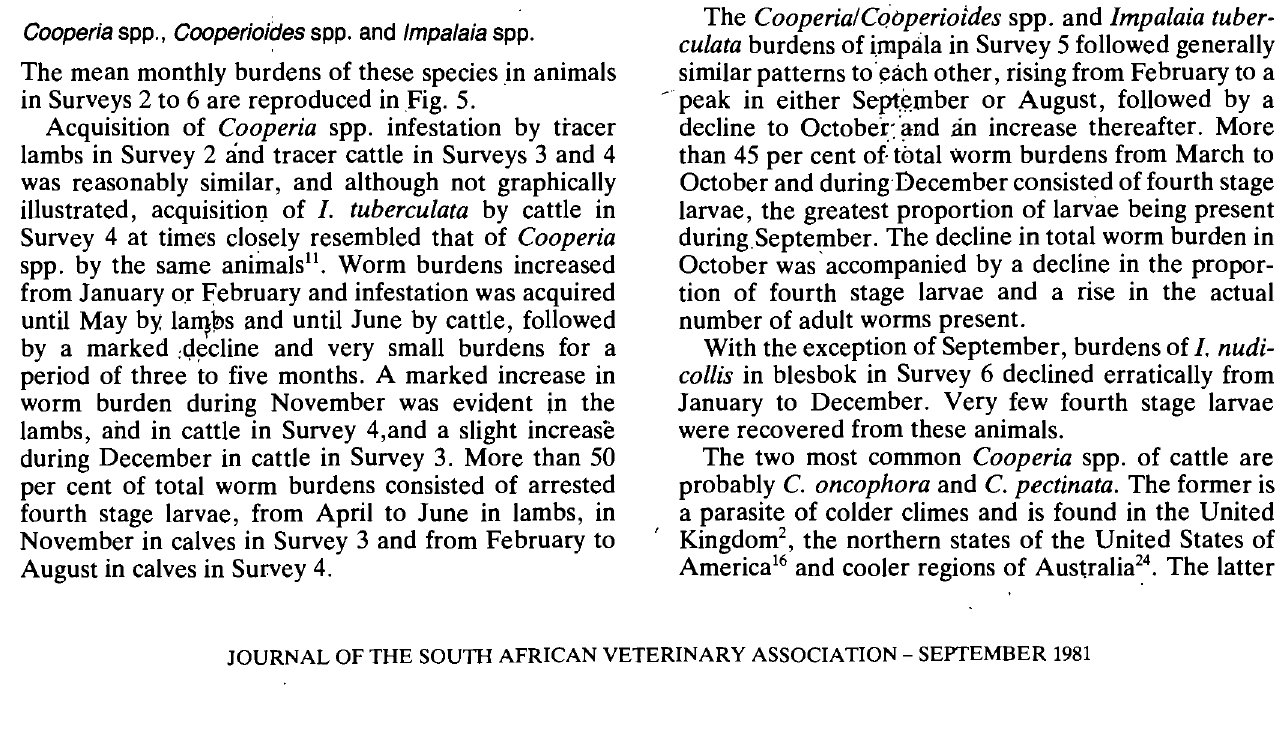
Fig. 5 The seasonal incidence of Cooperia spp. in sheep and cattle, Cooperia sp., Cooperioides spp. and Impalaia sp. in impala and Impala sp. in blesbok slaughtered in surveys conducted in the Transvaal. Survey 2 - sheep, SUrveys 3' and 4:-: cattle, Survey 5 - impala, Survey 6 - blesbok Cooperia spp., Cooperioides spp. and Impalaia